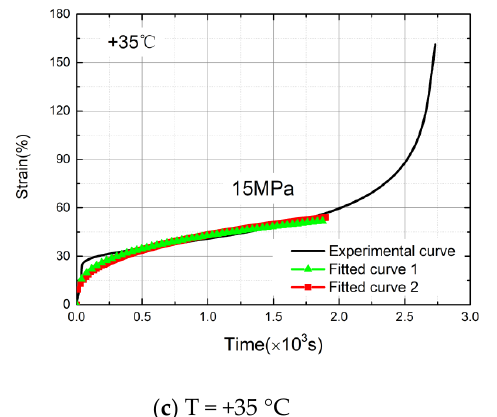
Figure 12. ( a ) Curve diagrams of 35 MPa stress at T = − 25 °C. ( b ) Curve diagrams of 23 MPa stress at T = +5 °C. ( c ) Curve diagrams of 15 MPa stress at T = +35 °C.